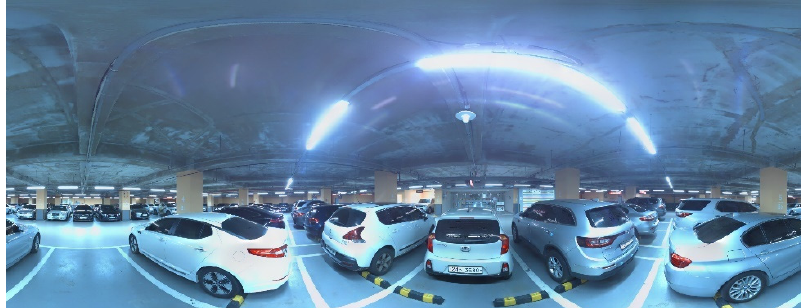
Figure 3. Acquired image data from scanning.